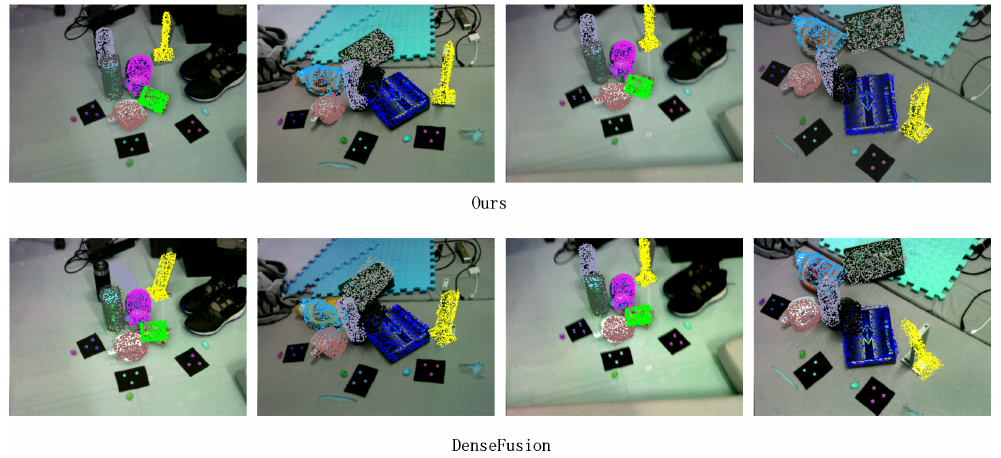
Figure 12. Quantitative evaluation of DenseFusion and the pose estimation network proposed in the paper on SIAT pose dataset.